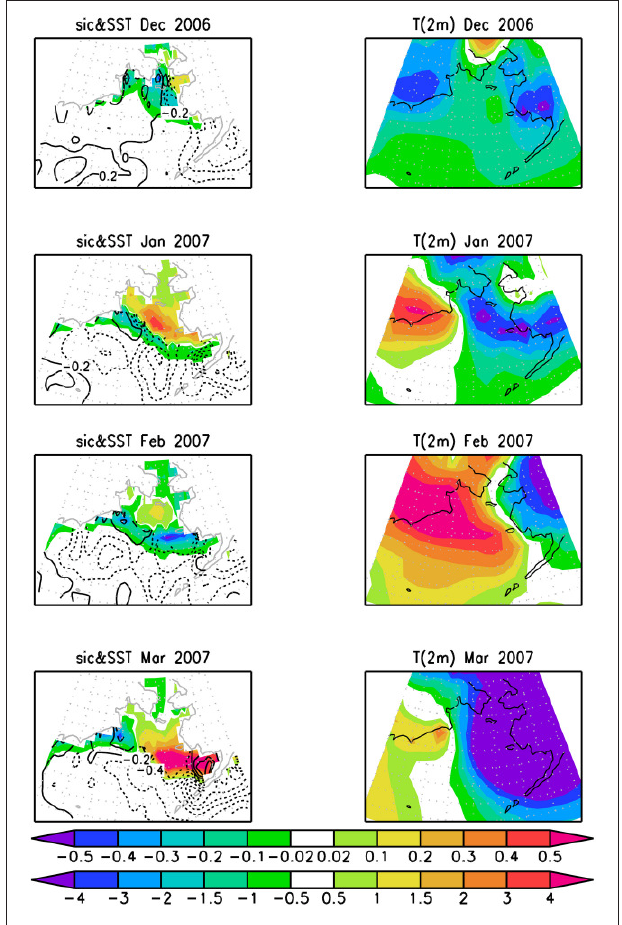
FIGURE 9 | Anomalies of sea ice concentration (100%, shading) and SST ( ◦ C, contour, interval: 0.2 ◦ C) (left), surface (2 m) air temperature ( ◦ C) (right) from December 2006 to March 2007 obtained as departure from 2000 to 2006 mean. The upper and lower color bar is for sea ice concentration and surface air temperature,